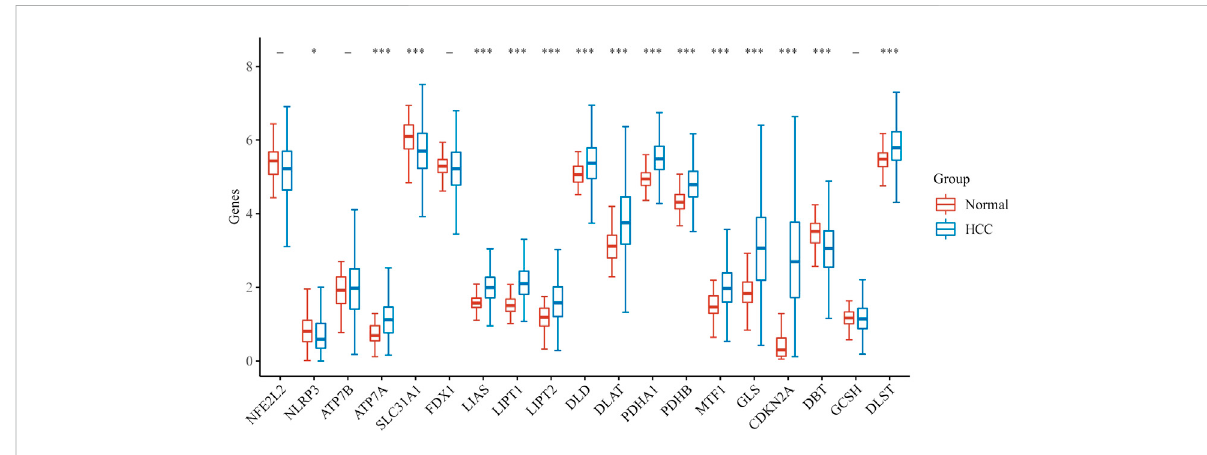
FIGURE 1 The expression of CRGs in HCC. (* p < 0.05, ** p < 0.01, *** p < 0.001, asterisks (*) stand for signi fi cance levels).